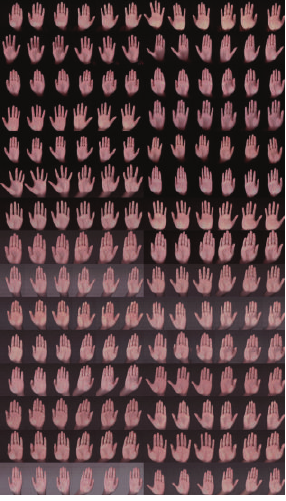
Figure 3: Database in